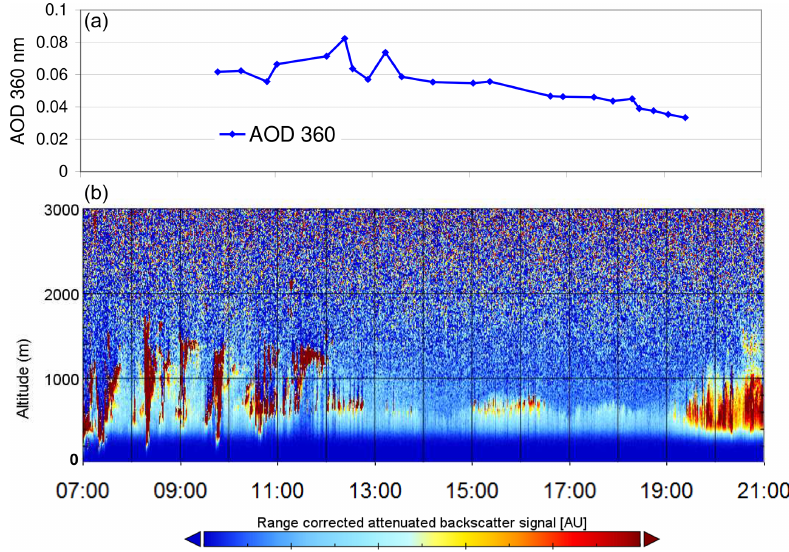
Figure 3. (a) AOD at 360nm measured from the hand-held Sun photometer. The data were extrapolated from the measurements at 380nm using the Ångström coefficient calculated from 380 and 440nm. (b) Range-corrected ceilometer backscatter profile at